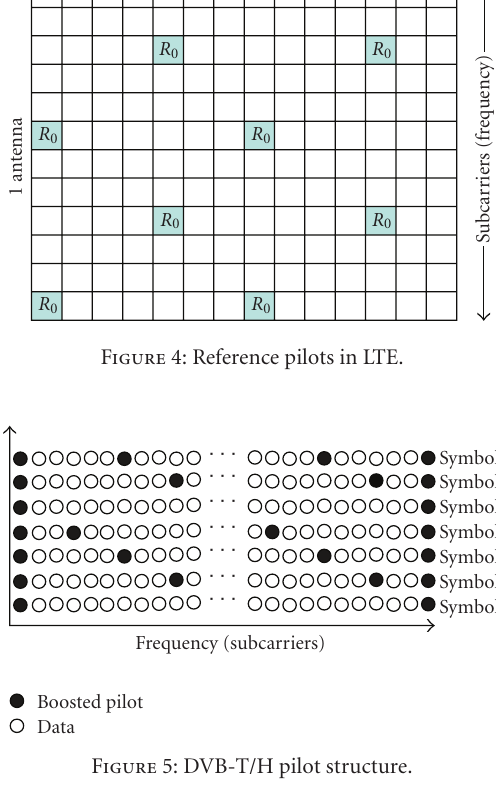
Figure 5: DVB-T/H pilot